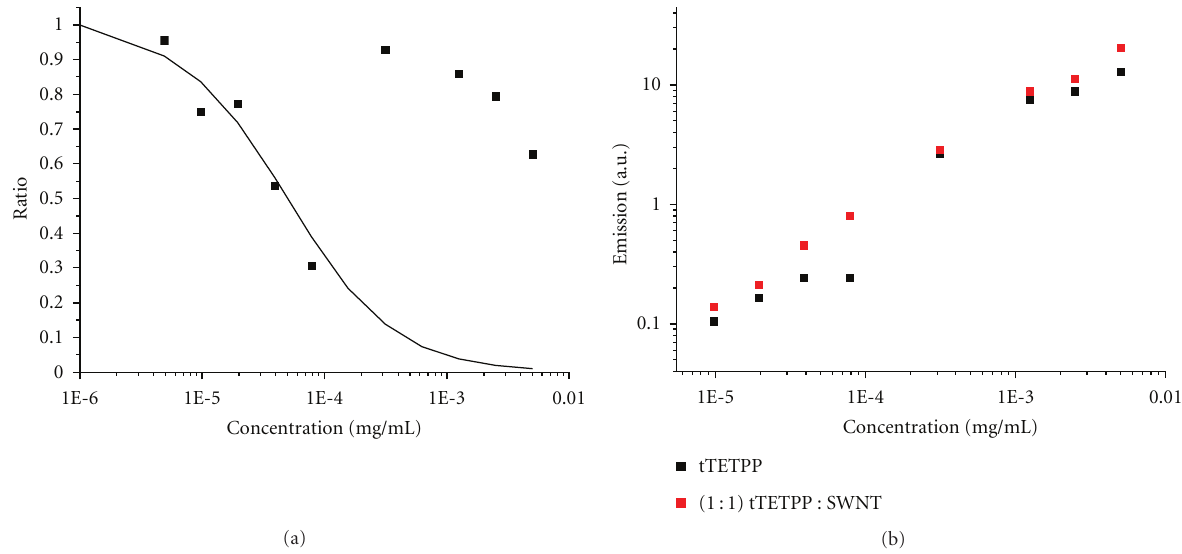
Figure 2: The PL quenching behaviour of tTETPP appeared to be in conservative agreement with the binding model at concentrations su ffi ciently dilute display an appreciable level of emission